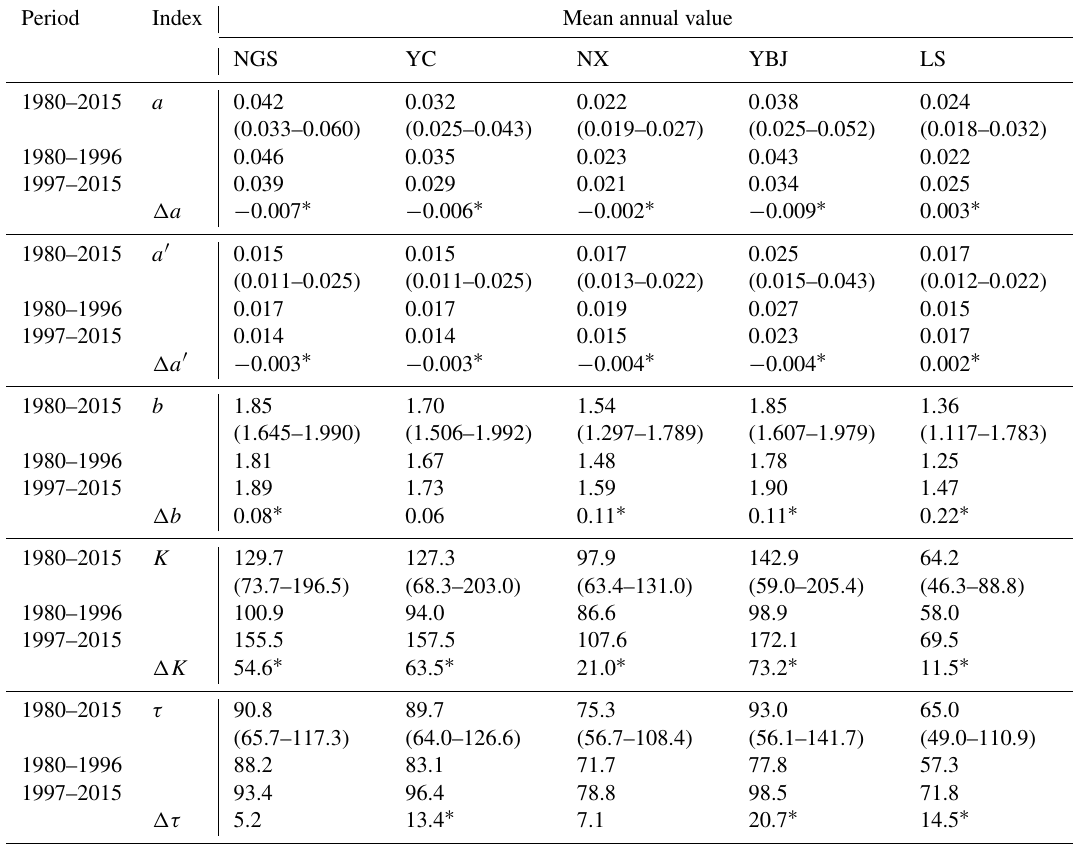
Table 3. Mean values of parameters a (mm 1 − b d b − 2 ), a (cid:48) (d − 1 ) and b (dimensionless), recession coefficient K (mm b − 1 d 2 − b ), and recession timescale τ